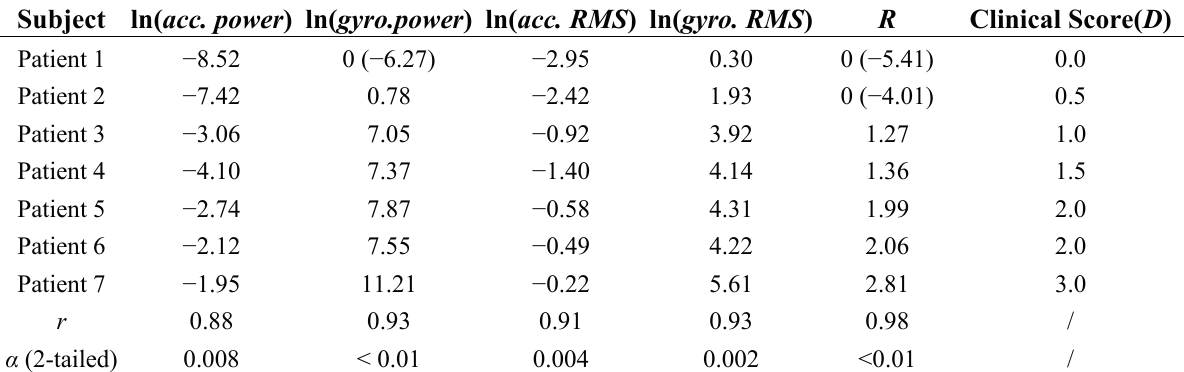
Table 1. Results for rest and postural tremor